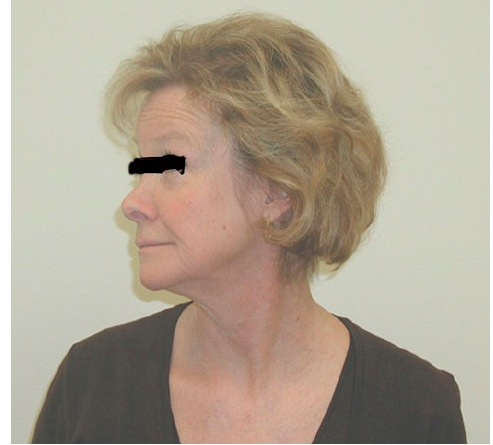
Figure 3. Neck rotation, chin toward shoulder.